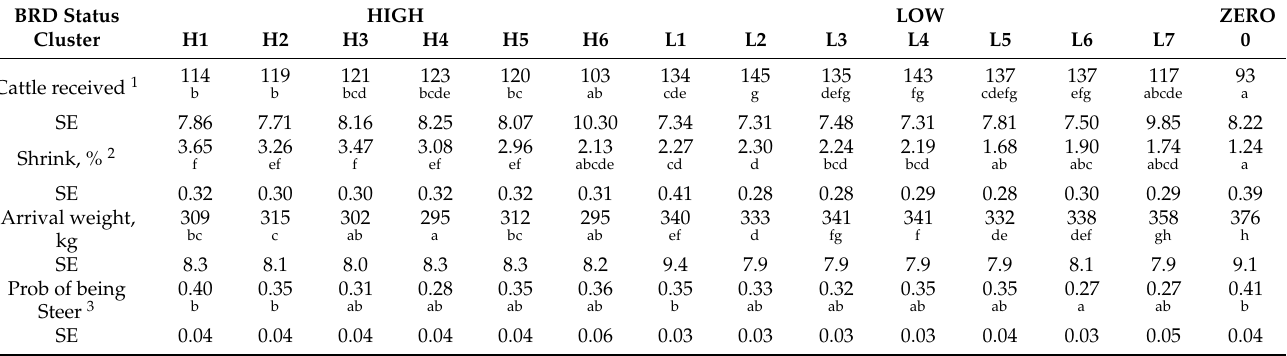
Table 2. Univariate model estimates of cohort demographics and their association by temporal clustering group using data from 10 US commercial feedlot operations. Feedlot cattle were grouped into HIGH ( ≥ 15%), LOW (>0 to <15%), or ZERO (0%) BRD cohort morbidity for clustering analysis. Differing letters within the same row indicate a statistical difference of p < 0.05 while estimates sharing a letter are not statistically different p >